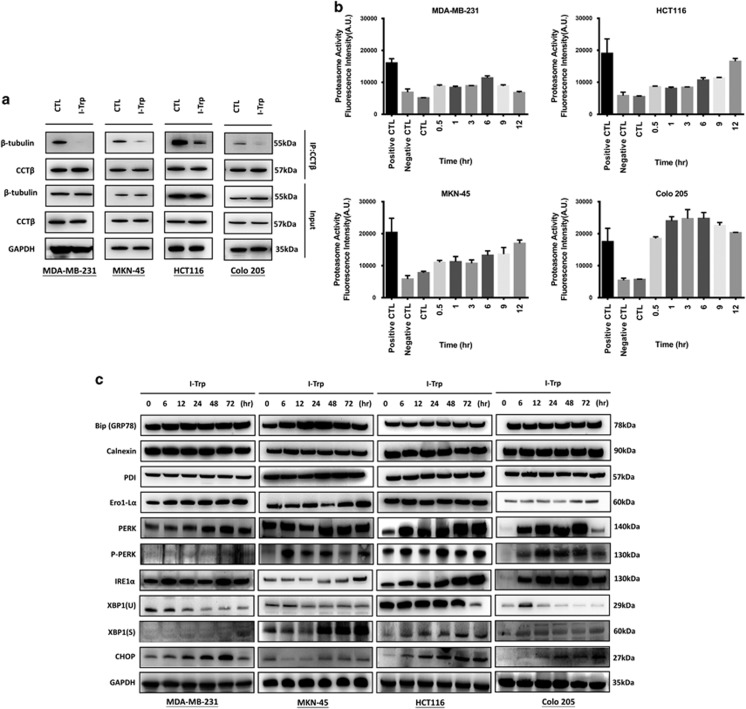
Disruption of CCT-β : β-tubulin by I-Trp. (a) Using CCT-β antibody to co-IP the complex, and then detecting the quantity of trapped β-tubulin with western blotting using β-tubulin antibody. The trapped β-tubulin in the cancer cells was reduced in quantity upon I-Trp treatment, indicating I-Trp blocked the PPI. (b) Targeting the CCT-β : β-tubulin complex with I-Trp promotes proteasome activity. The cancer cells were treated with I-Trp for the designated time periods. Cell lysates were examined using the proteasome activity assay. (c) The changed expression levels of ER stress protein markers upon I-Trp treatment